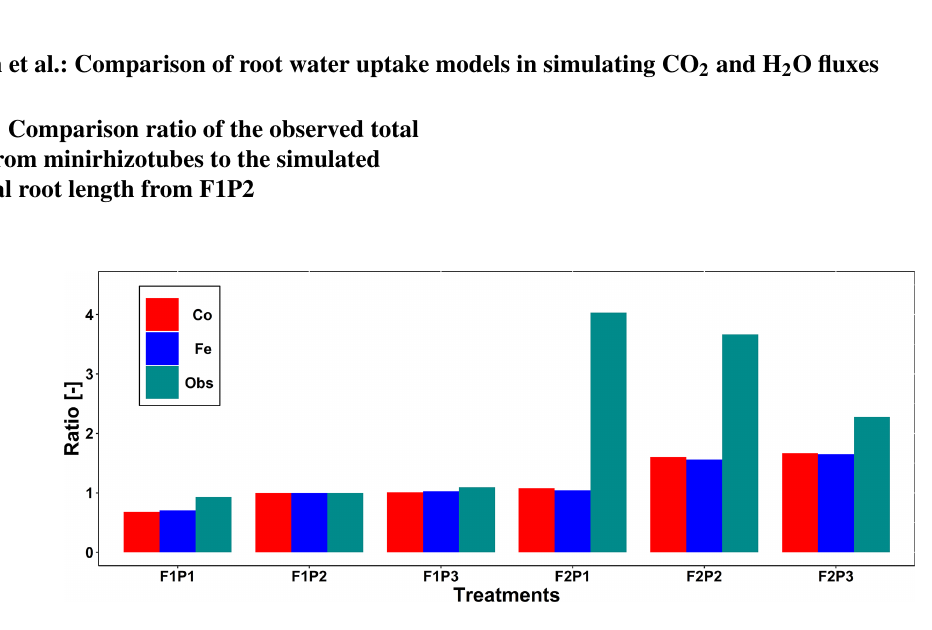
Figure F1. Comparison ratio of the observed total root length from minirhizotubes to observed total root length from F1P2 (green line with squares) and ratio of simulated total root length to the simulated total root length from F1P2 on 11 July 2016 (DOY 193) from the Couvreur (Co; solid red, dots) and Feddes (Fe; solid blue, triangles) model in the sheltered (P1), rainfed (P2), and irrigated (P3) plots of the stony soil (F1) and the silty soil (F2).